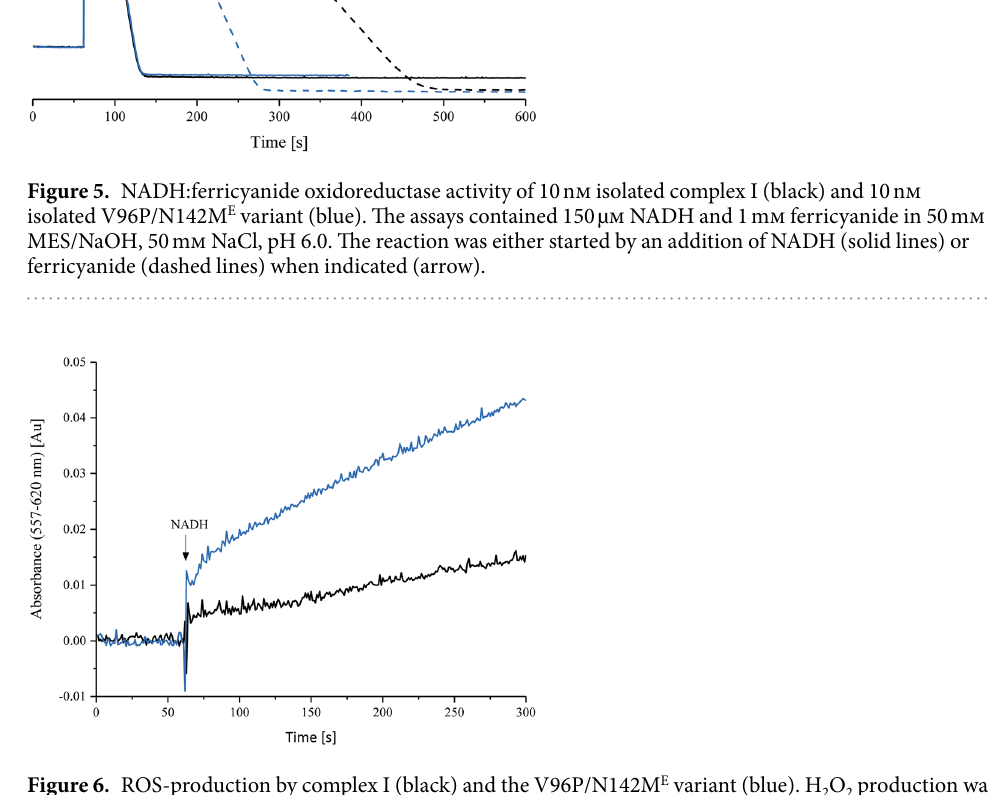
Figure 6. ROS-production by complex I (black) and the V96P/N142M E variant (blue). H 2 O 2 production was measured with the Amplex-red assay using 2 nm protein, horseradish peroxidase (2 U ml − 1 ), 10 µ m Amplex-red and 30 µ m